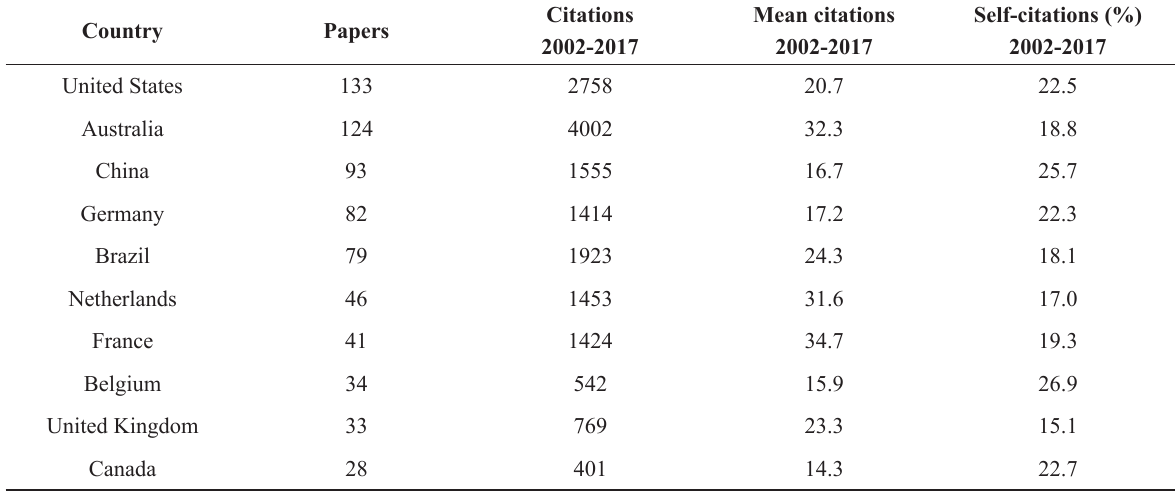
Comparison of the 10 countries with most published DMS papers between 1996 and 2017 and citations, mean citations per paper and self-citations between 2002 and 2017.